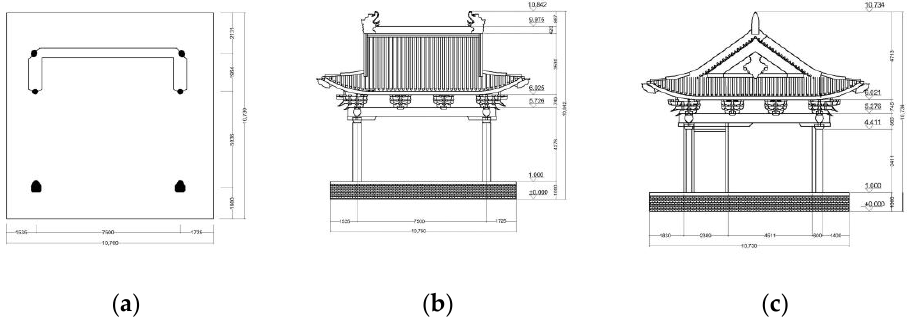
Figure 6. CAD drawing of the Niuwang Temple Stage. ( a ) Plane. ( b ) Facade. ( c ) Side elevation.